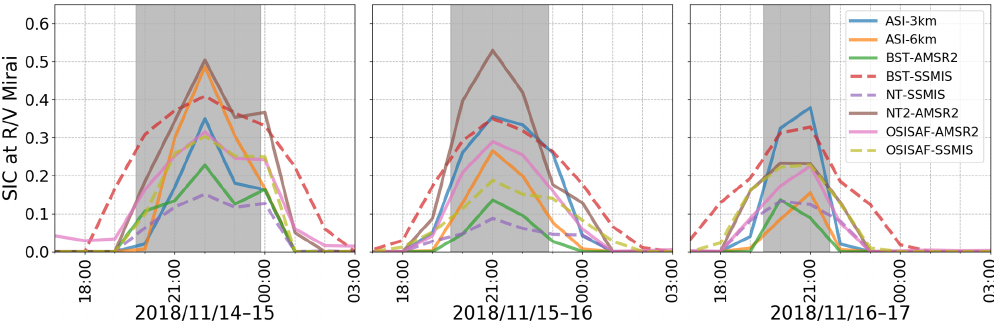
Figure D3. Satellite-retrieved SIC for all products along the R/V Mirai track during Phase 2 between 14 and 16 November 2018. The figure schematics follow Fig. D2.